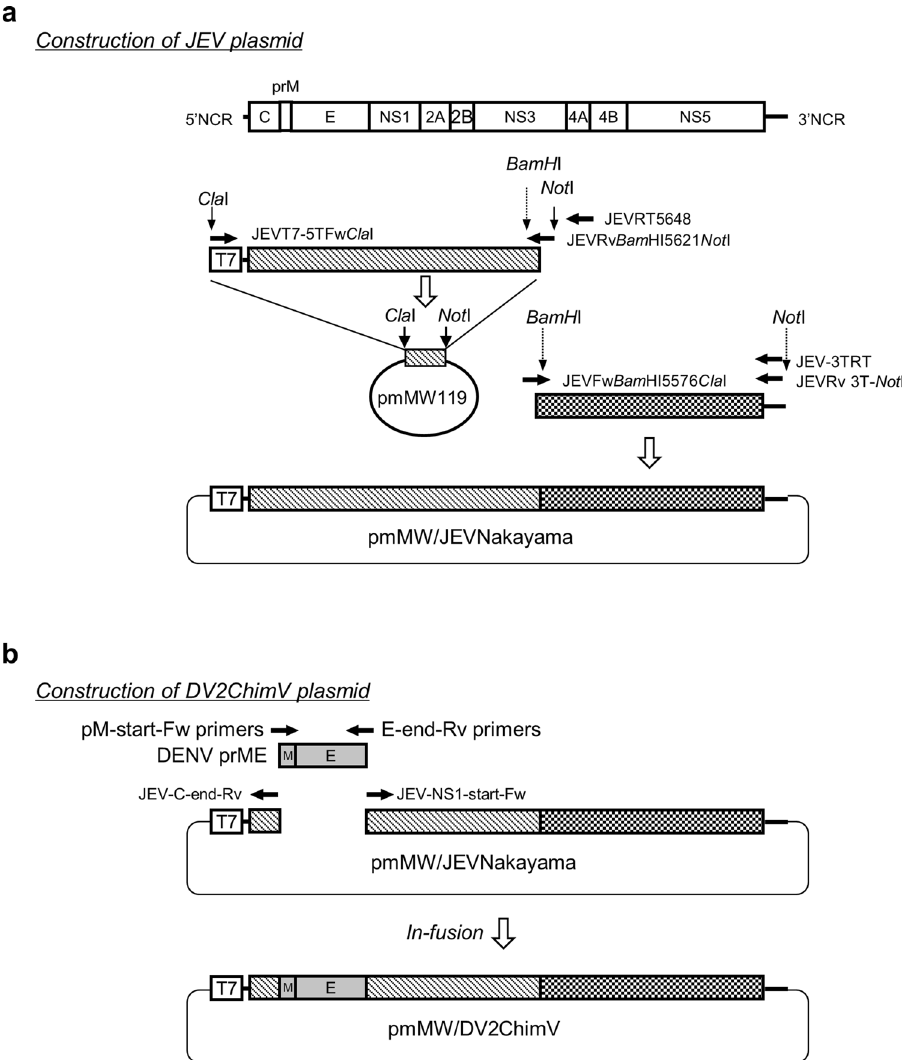
Figure 6. Schematic representation of the strategy used to construct the recombinant plasmids pmMW/ JEVNakayama and pmMW/DV2ChimV. ( a ) pmMW/JEVNakayama was constructed by insertion of the Japanese encephalitis virus (JEV) genome and the T7 promoter sequence into pmMW119 between the ClaI and NotI sites. ( b ) The premembrane (prM) and envelope (E) gene sequences of pmMW/JEVNakayama were replaced with the corresponding DENV-2 R05-624 prME gene